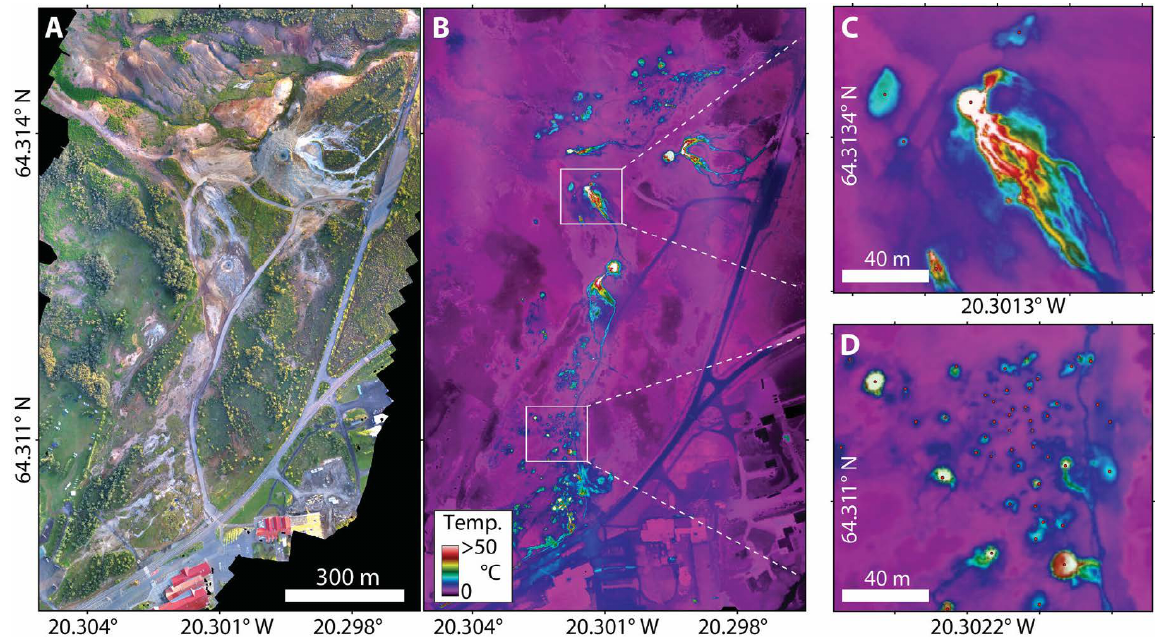
Figure 12: Thermal and visible-wavelength imaging identifying hot-pot features within the Geysir geothermal field, Iceland [Walter et al. 2018a]. The results represent example regions from full datasets of >7000 infrared and 1500 visible-wavelength images covering ~1.01 km 2 , collected from 80–140 m above the ground with a DJI Matrice 100 multi-rotor UAS. [A] Visible-wavelength orthomosaic from imagery collected with a DJI Zenmuse X5R. [B] The same region as a thermal orthomosaic (with boxed areas enlarged in [C] and [D]), from imagery collected under atmospheric temperatures of ~2 °C (03:00 local time), with a FLIR Tau 2 (giving a mean GSD of ~17